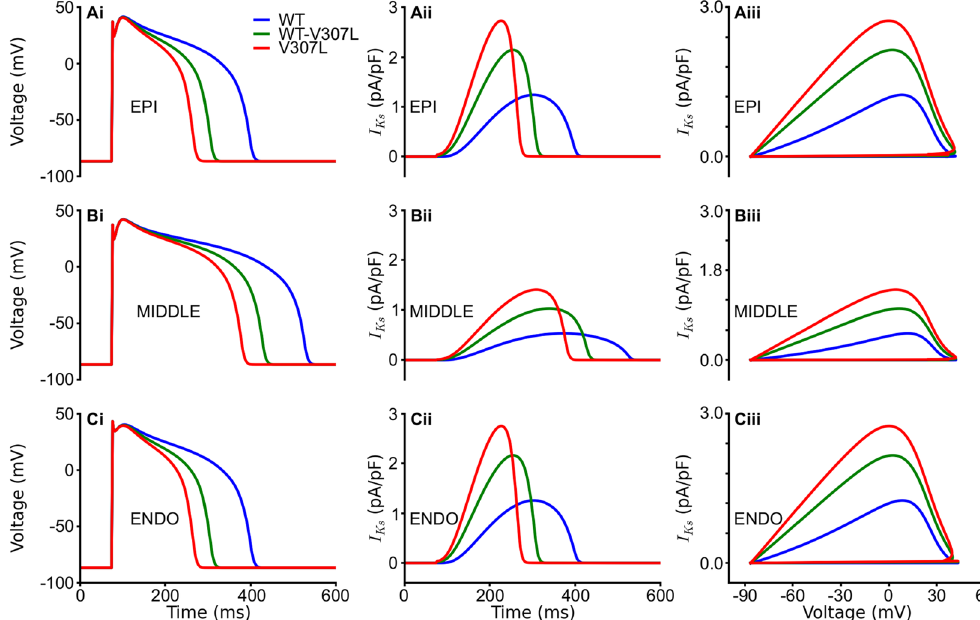
Figure 2. Action potentials and I Ks profiles. Steady state APs (i) for EPI ( A ), MIDDLE ( B ), and ENDO ( C ) cells in WT (blue), WT-V307L (green), and V307L (red) conditions at a pacing rate of 1 Hz. Corresponding I Ks profiles (ii) and I-V relationships (iii) for EPI ( A ), MIDDLE ( B ), and ENDO ( C ) cells.